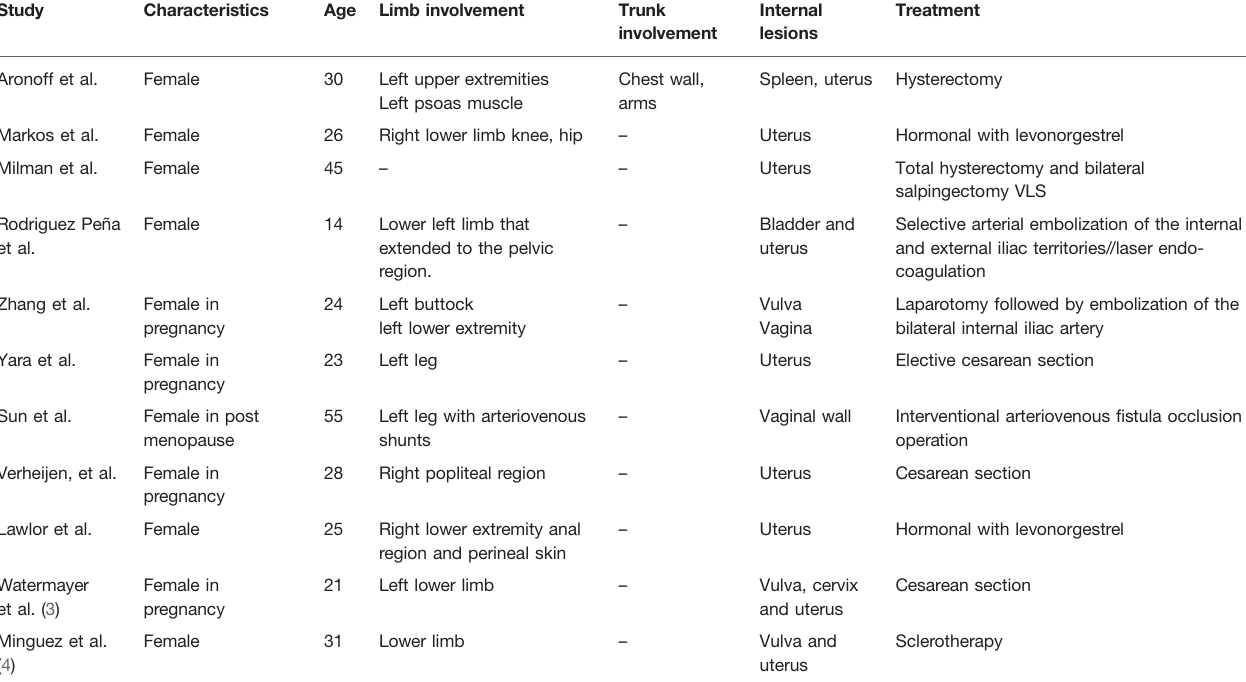
TABLE 1 | Uterine involvement of Klippel – Trenaunay syndrome and respective